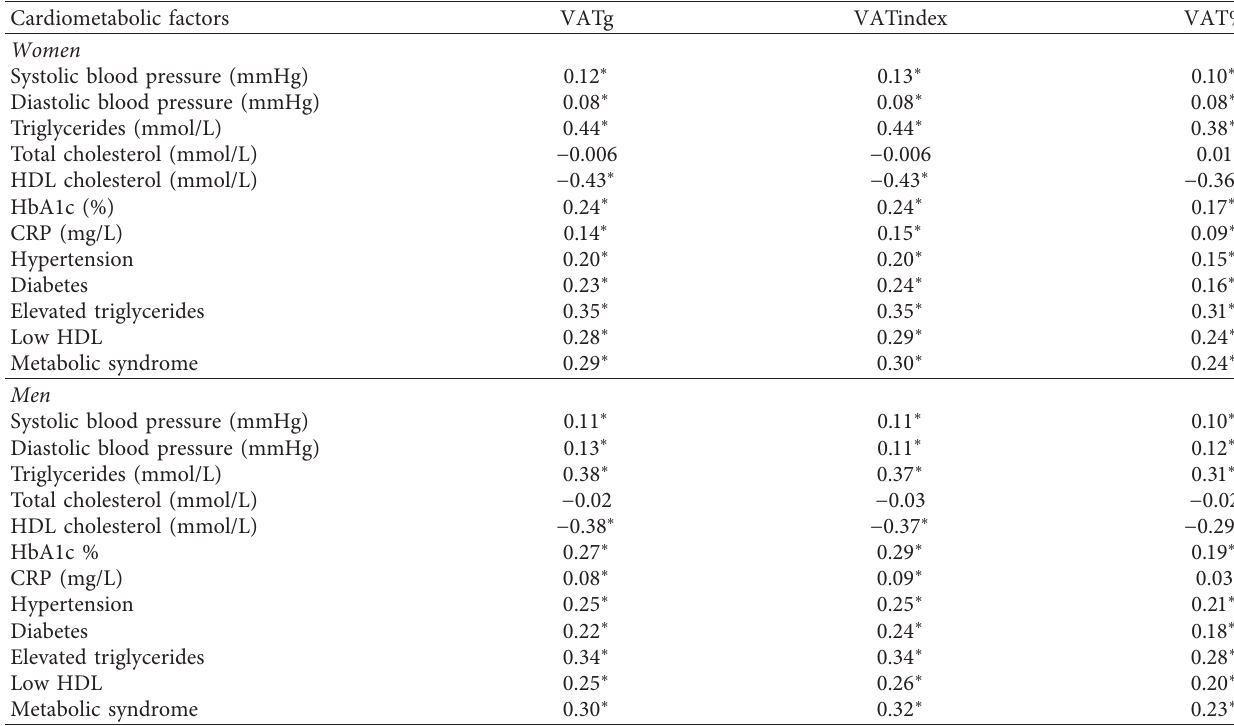
Table 2: Age-adjusted correlation for the association of VATg, VATindex, and VAT% with cardiometabolic risk factors: the Tromsø Study 2015–2016.